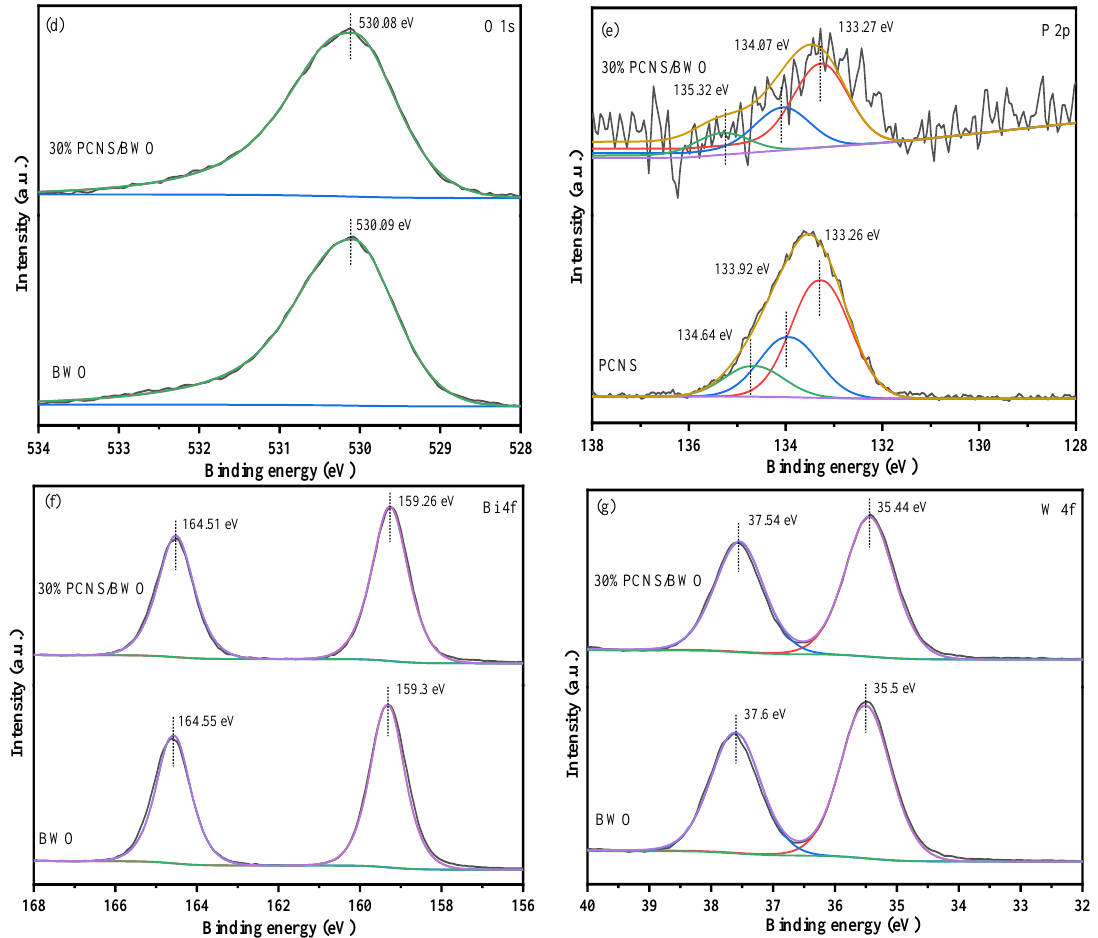
Figure 2. XPS data of PCNS, BWO, and 30% PCNS/BWO: ( a ) survey, ( b ) C 1s, ( c ) N 1s, ( d ) O 1s, ( e ) P 2p, ( f ) Bi 4f, and ( g ) W 4f spectra. The chemical structures of the samples were further analyzed by FTIR spectroscopy, as shown in Figure 3. The spectra of CNS and PCNS were very similar. The absorption bands at 3000 – 3600, 1200 – 1650, and 810 cm −1 correspond to N – H stretching vibrations, C – N heterocyclic stretching vibrations, and the triazine structure of g-C 3 N 4 [37], respectively. This result confirms that P doping did not change the triazine ring structure of CNS, which is consistent with the XRD results. As the PCNS/BWO ratio increased, the intensities of all the peaks gradually increased. In the BWO spectrum, the absorption bands at 579, 731, 827, and 1380 cm −1 correspond to Bi – O – Bi stretching vibrations, W – O – W bonds, Bi – O stretching vibrations [38], and the vibration of the adsorbed water molecules [39], respec- tively. With increasing PCNS content, the peaks at 1380 and 827 cm −1 gradually disap- peared, while those at 579 and 731 cm −1 gradually reduced. The characteristic peaks of PCNS and BWO coexisted in the spectra of the PCNS/BWO composites, indicating the successful construction of PCNS/BWO heterojunctions.